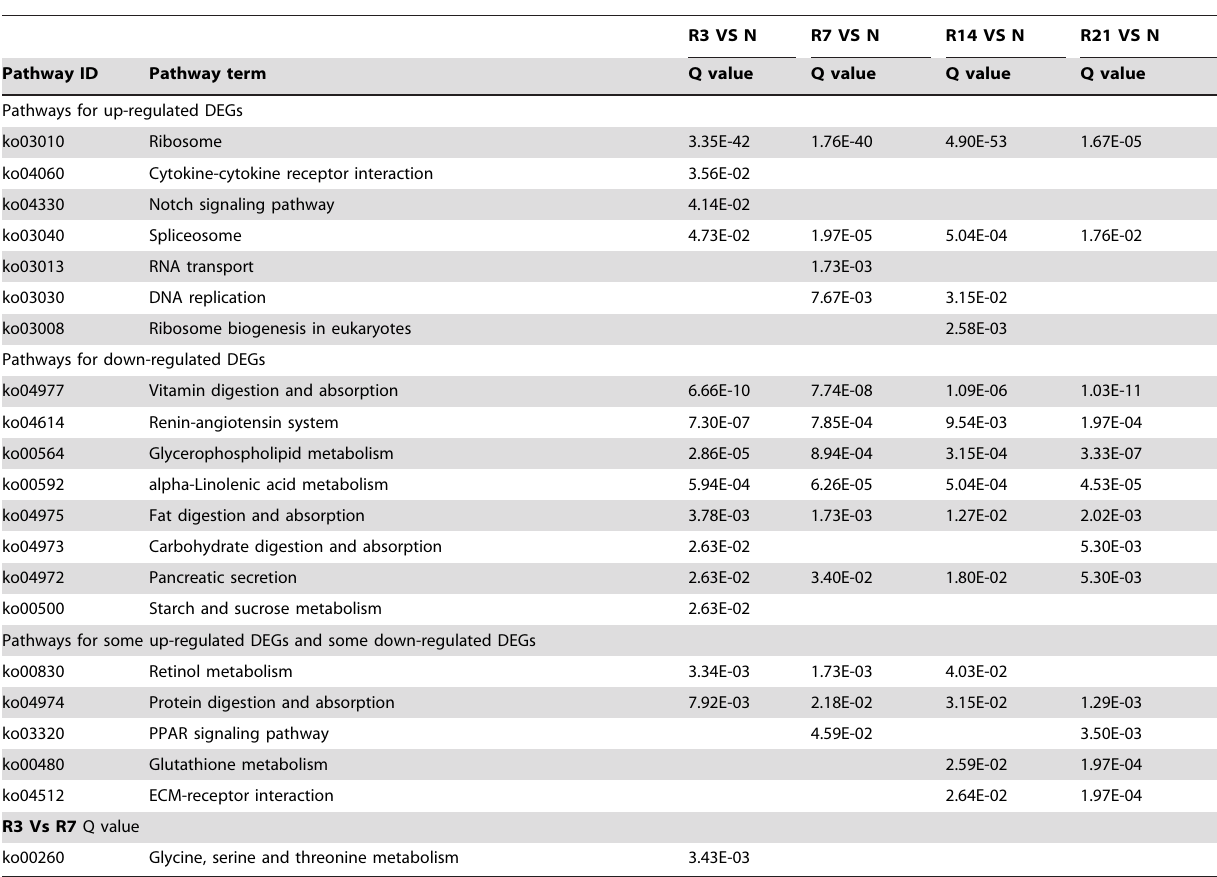
Table 9. Significantly enriched pathway in DEGs.